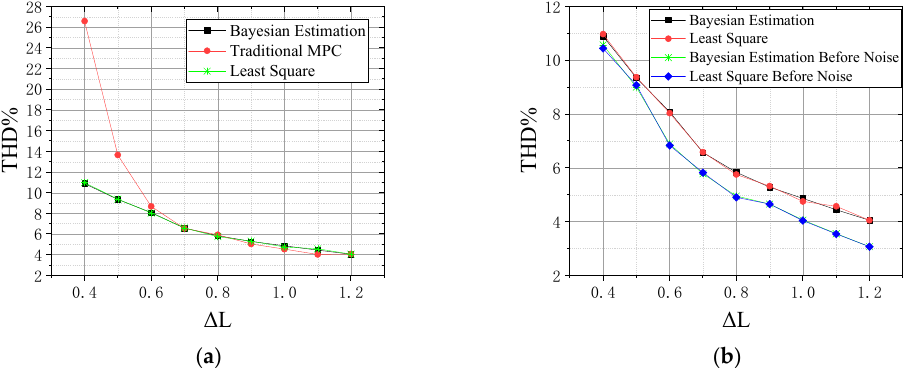
Figure 12. THD of current when adding white noise as inductance parameter changes. ( a ) THD of current after adding noise; ( b ) THD of current before and after adding noise.